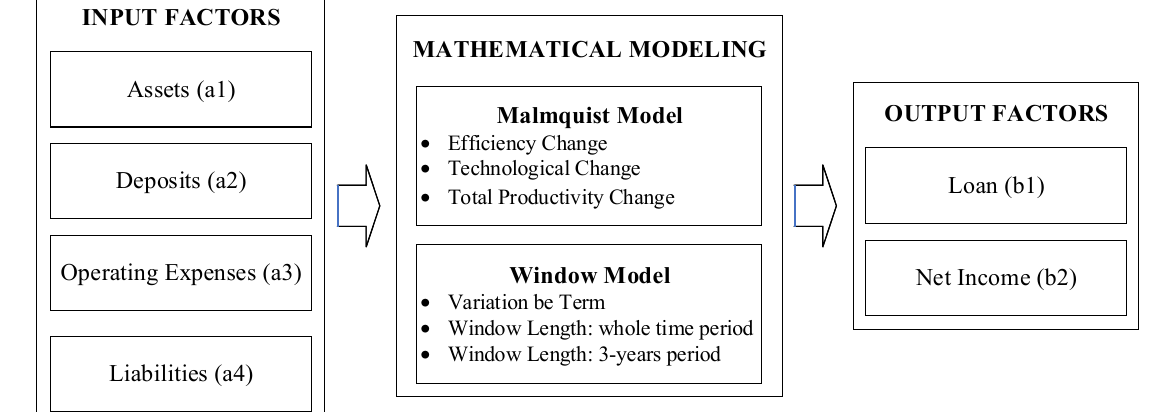
Figure 1. The modeling framework of the research.